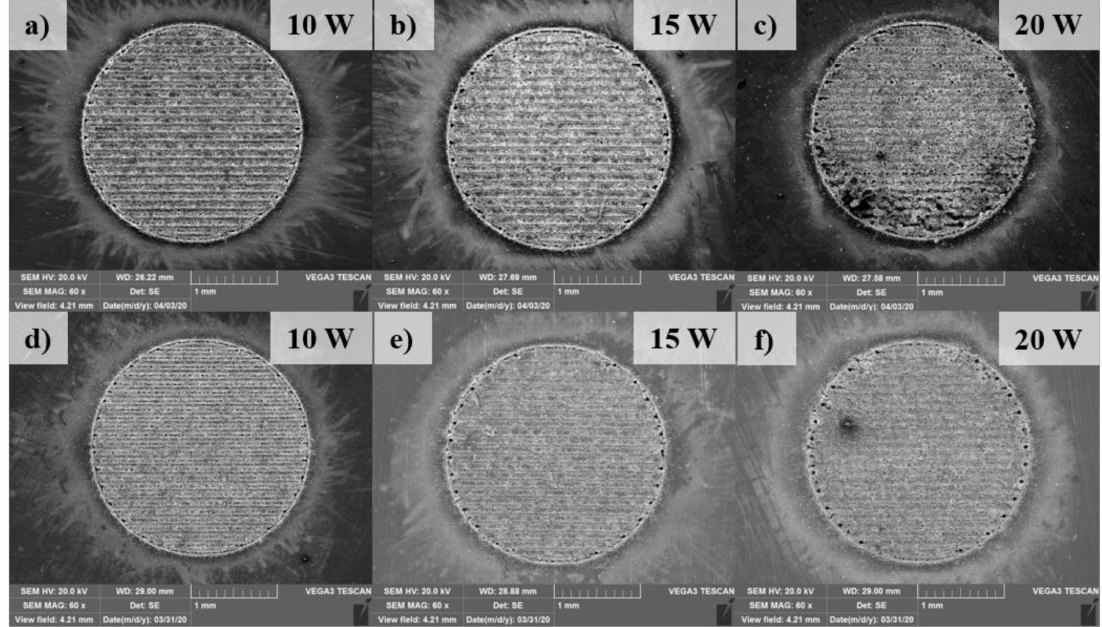
Figure 5. SEM images of the overview welding zone on the top surface. ( a – c ): Welding without the metal tube; ( d – f ): Welding with the metal tube.